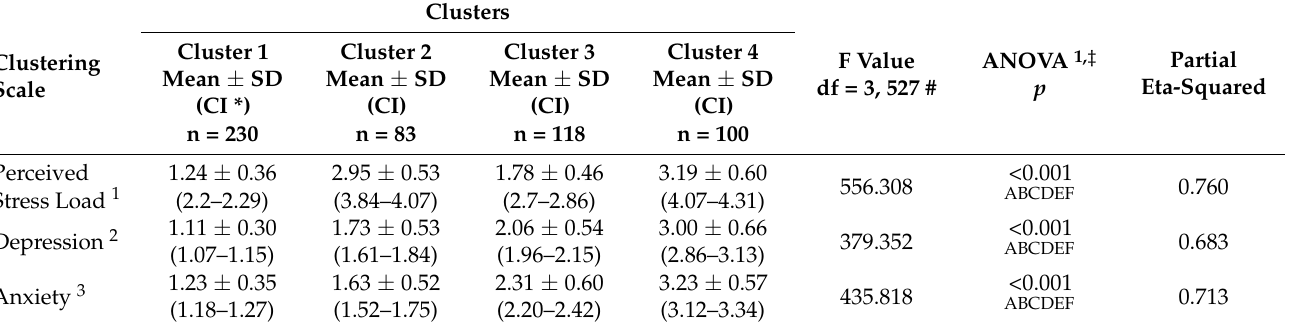
Table 1. Comparison of Maternal Mental Health Status Clusters (N =